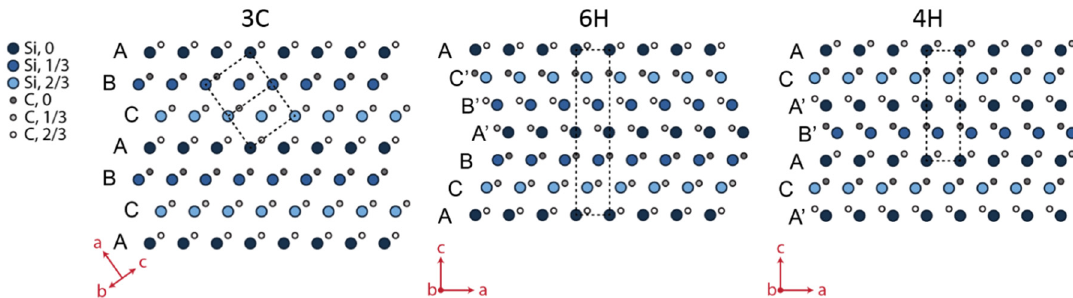
Figure 1. 3C-, 6H- and 4H-SiC structures can be interpreted through the orientation of alternating Si and C layers [7,8]. The unit cell in each case is represented by a dashed line. The layers are labelled based on relative stacking position and depth coming out of the page.